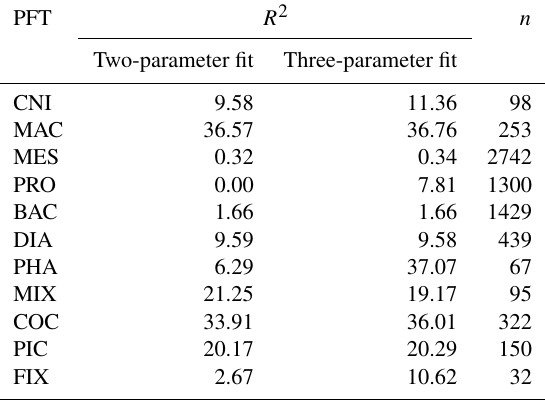
Table A2. The fit to the growth data for PFTs for the new three-parameter fit used in this study (see Eq. 3 and Fig. 2) and the two-parameter fit (see Eq. 2 and Fig.